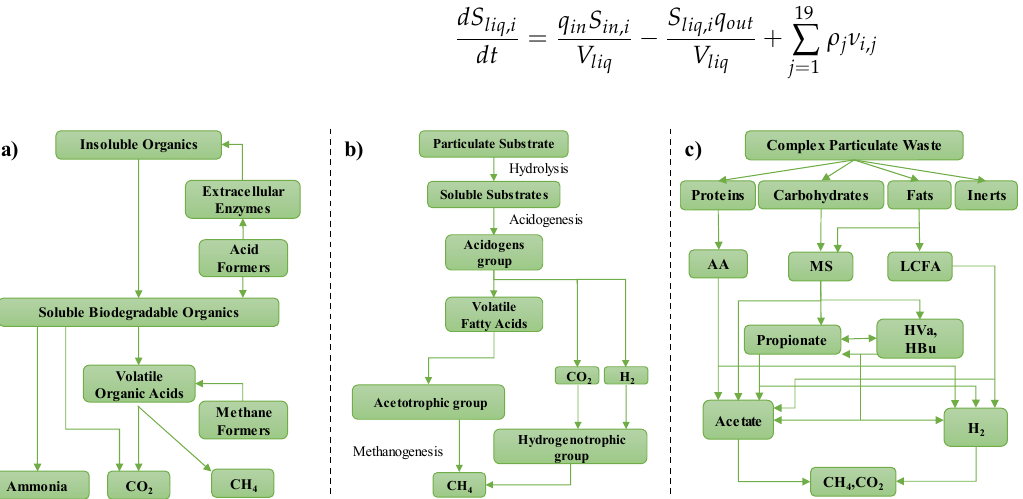
Figure 2. AD models: ( a ) Husain (1998) [83]; ( b ) Zaher et al. (2009) [85]; ( c ) Batstone et al. (2002) [10] (AA: amino acids; MS: monosaccharides; LCFA: long-chain fatty acids; HVa: valeric acid; HBu: butyric acid).